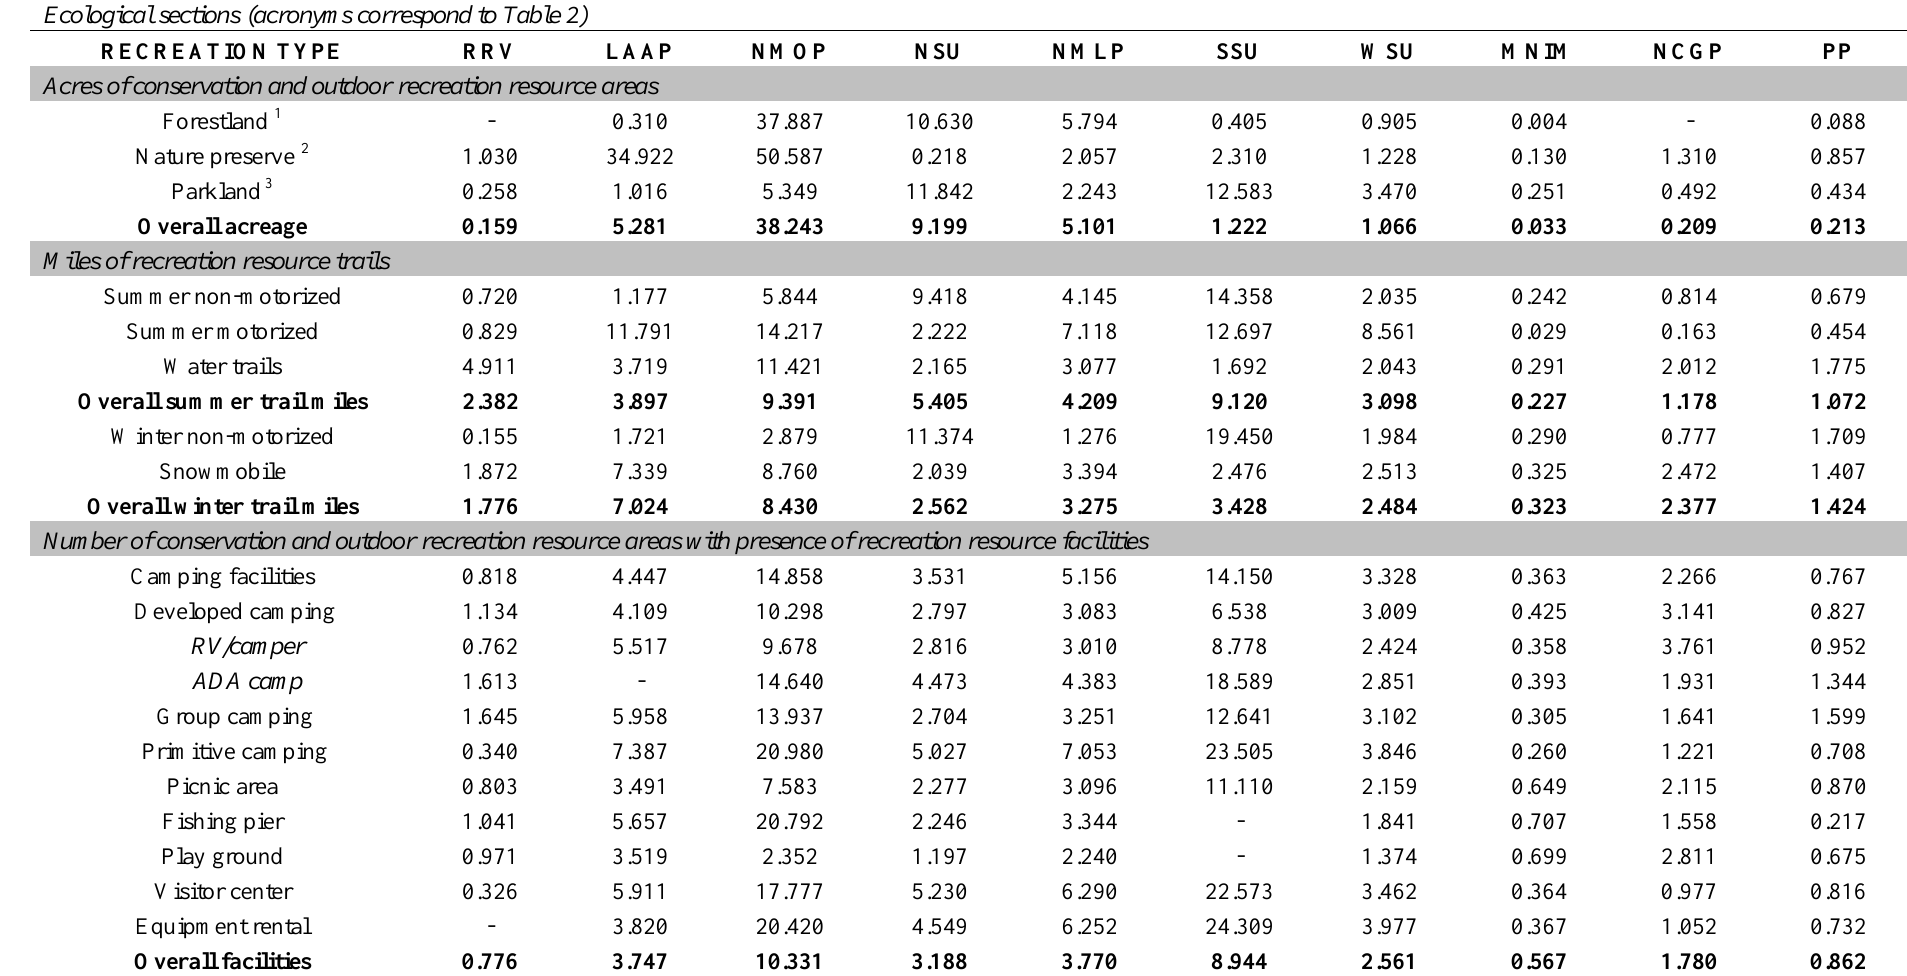
Table 5. Population-based recreation location quotients by ecological section. Ecological sections (acronyms correspond to Table